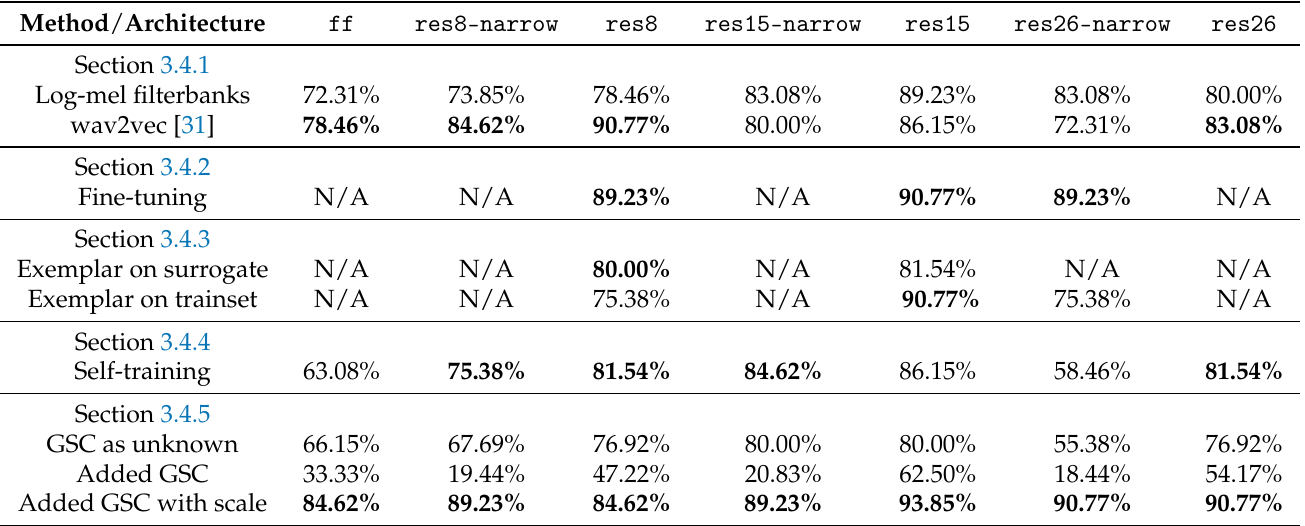
Table 16. Test accuracy from the experiments of this work. The results that are better than the log-mel filterbanks baseline are